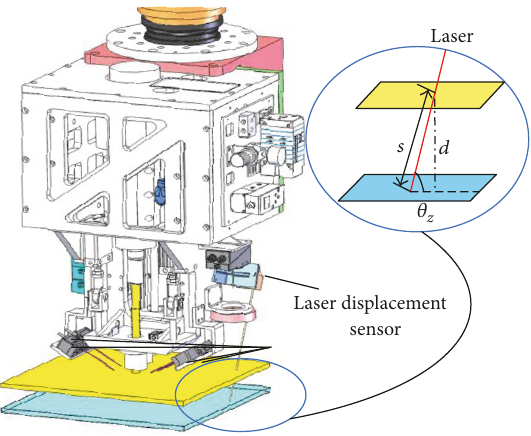
Figure 5: Direction calibration of laser displacement sensor.